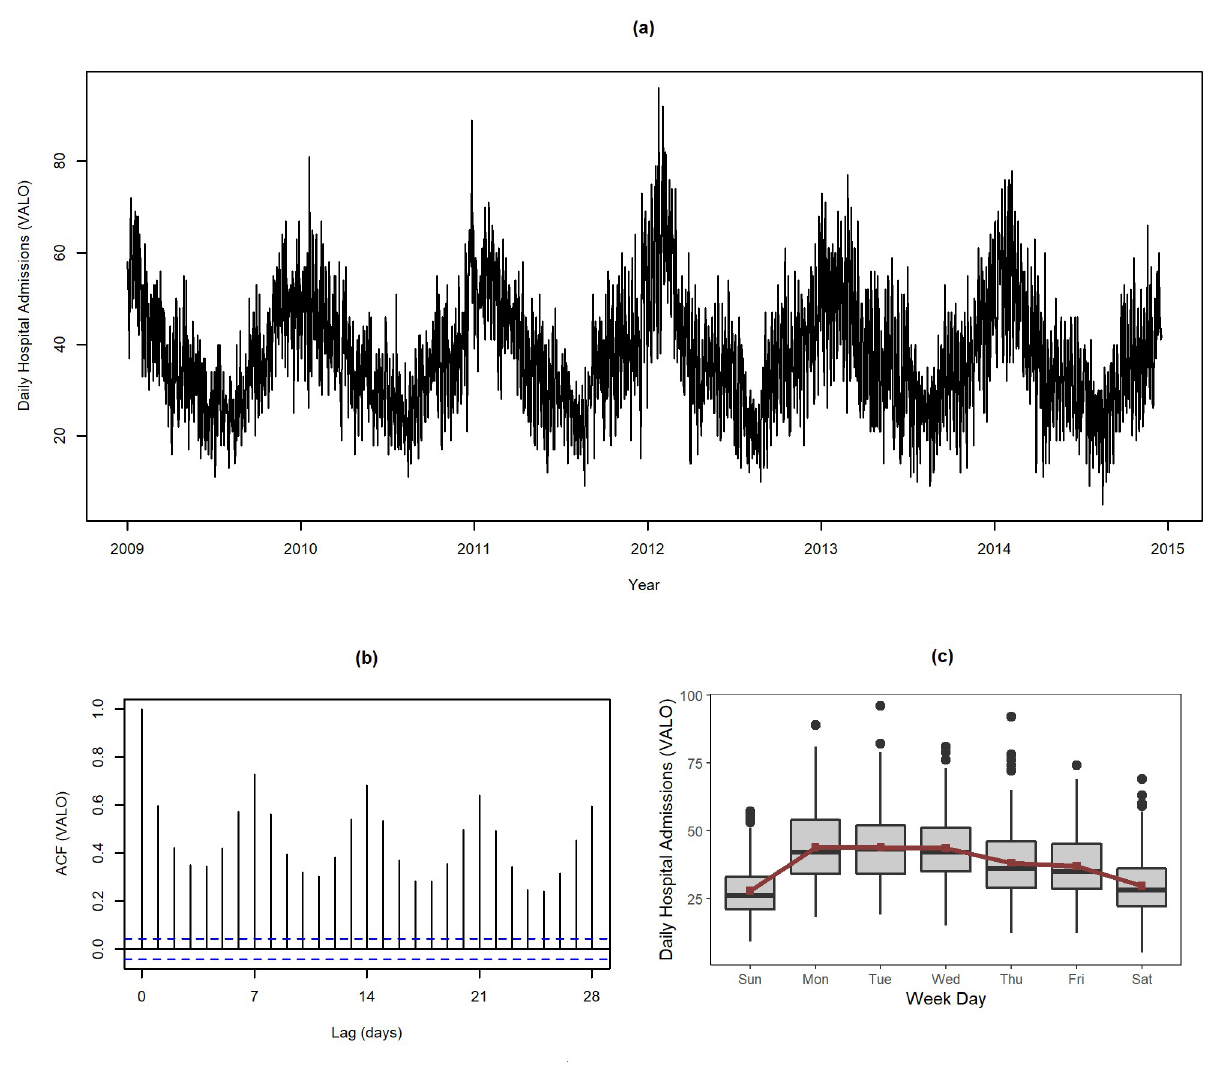
Fig 1. Number of daily hospital admissions at Valongo (VALO) from 2009 to 2015. (a) time series, (b) sample ACF and (c) distribution (box plots) and averaged values (red color dots and line) per day of the